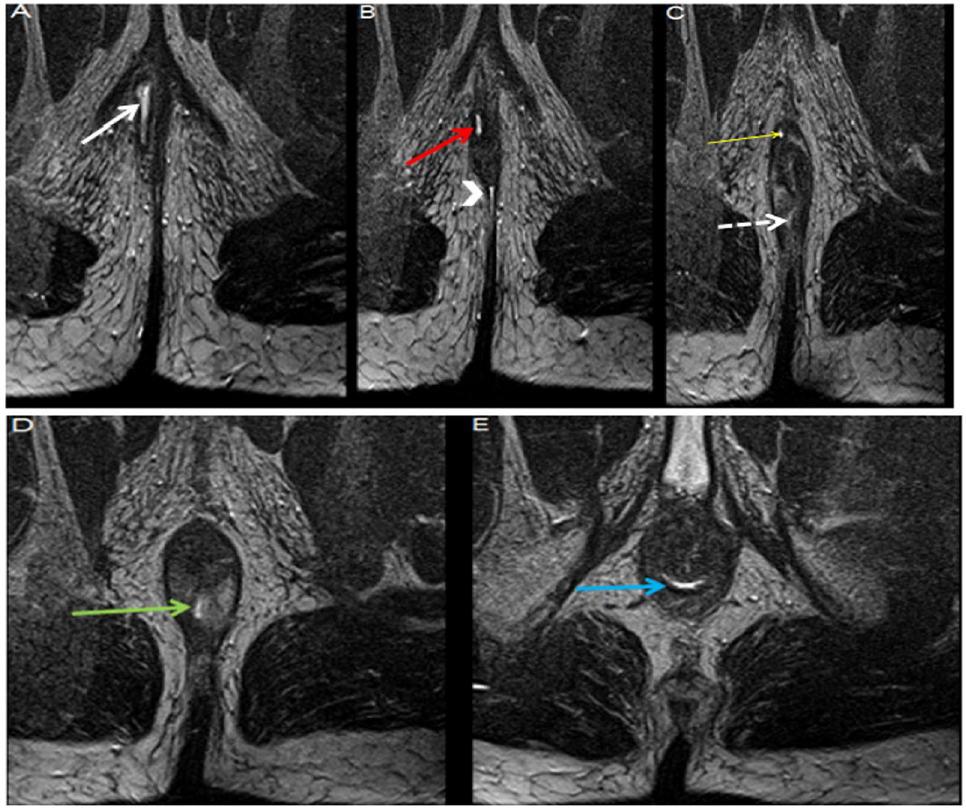
Fig. 5 A 50-year-old male patient presented with discharging fistulous openings. MRI examination in the form of multiple pulse sequences after local injection of saline and gel revealed in axial T2 images ( A – E ): A External cutaneous opening of the fistulous tract at the right perianal region (white arrow). B Fistulous tract at the intersphincteric space (red arrow) with another posterior midline fistulous tract (arrowhead). C Internal mucosal opening at 11 o’clock (yellow arrow). The posterior midline tract was seen in the intersphincteric space (dashed arrow). D The internal mucosal opening of the posterior midline tract was located in the anal canal at six o’clock (green arrow). E Extended branches on both sides of the anal canal giving a horseshoe appearance (blue arrow). The final diagnosis was a right, grade II, intersphincteric fistula